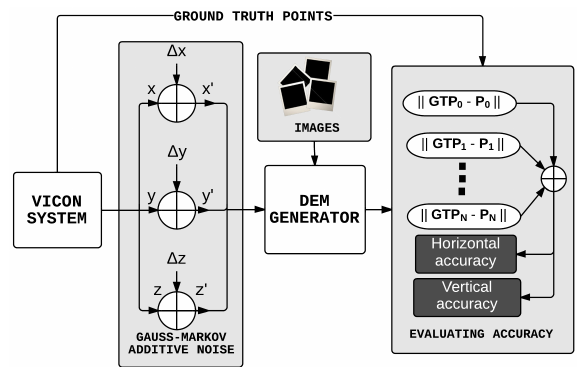
Figure 4: GPS simulation